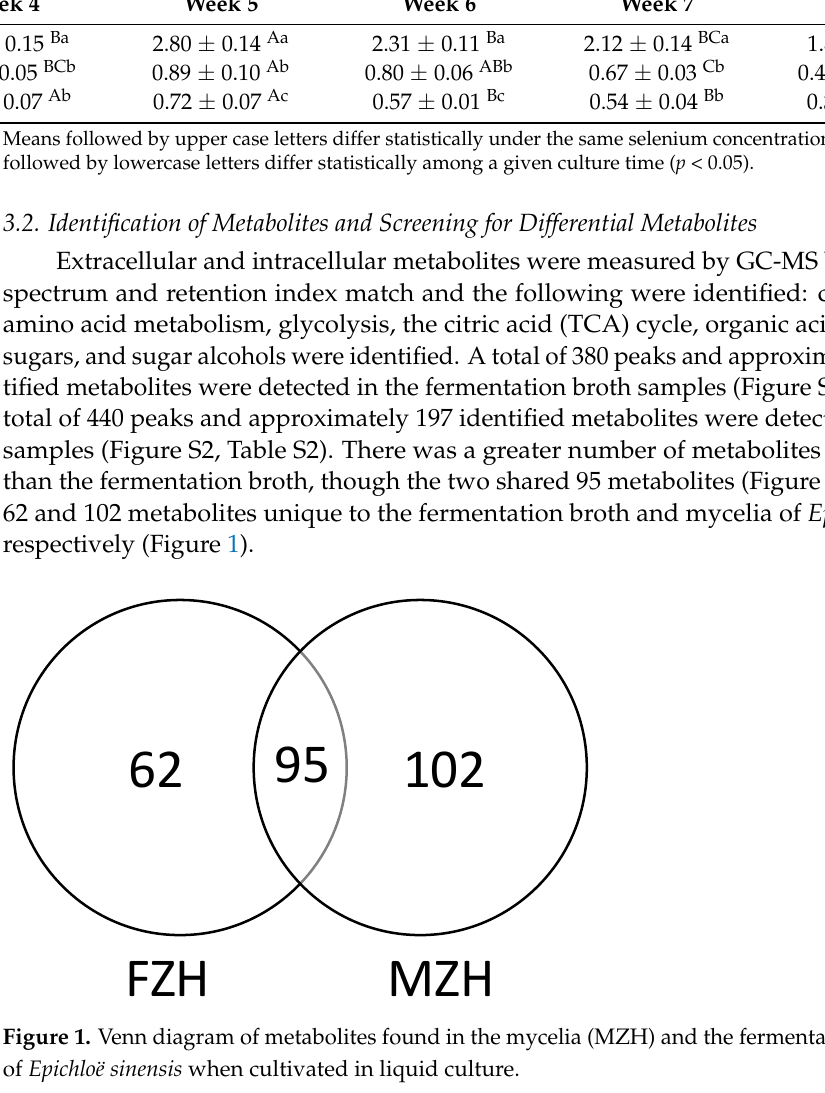
Table 1. Effects of Na 2 SeO 3 concentrations on mycelial dry weight of Epichloë sinensis in liquid culture. Se Concentration